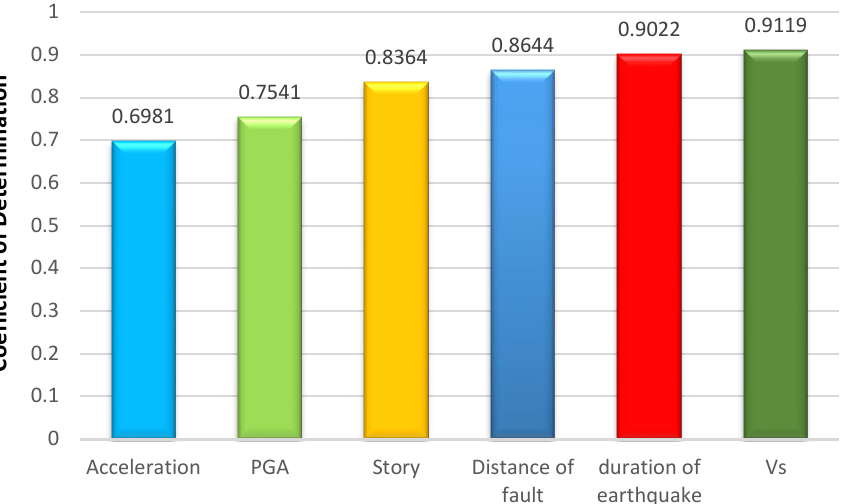
Fig. 6. The coefficient of determinations when each input parameter is removed in the ANFIS modeling